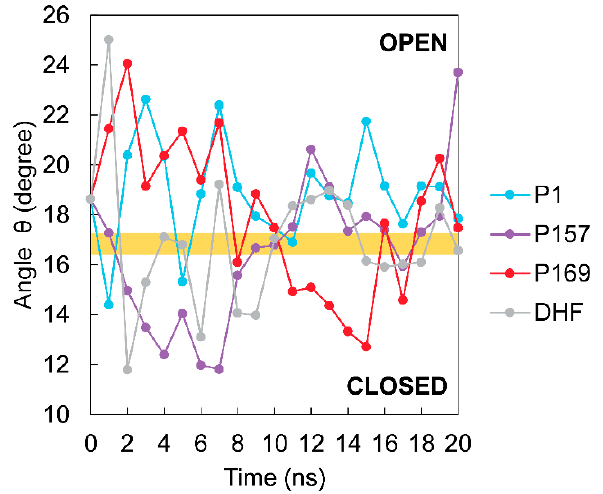
Figure 5. θ angle of mtbDHFR conformation at every 1-ns time interval of each MD simulation system: P1 (blue), P157 (purple), P169 (red), and DHF (gray). The orange shading indicates the upper bound and lower bound of closed and open conformations.